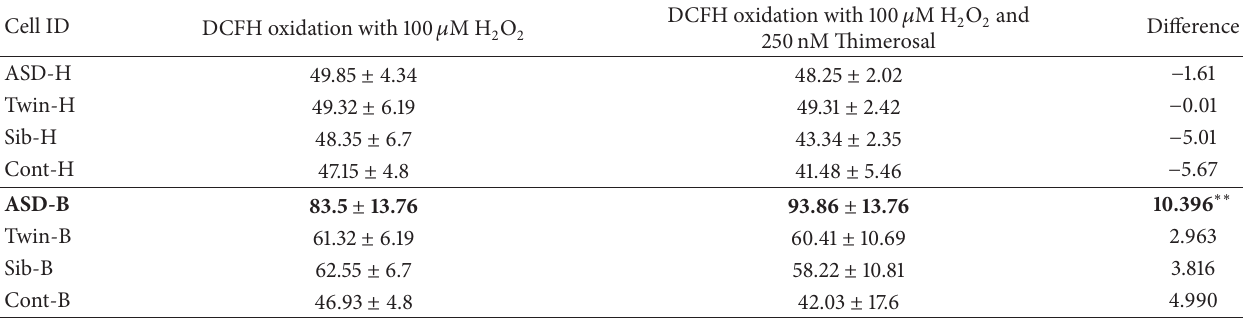
∗∗ Indicates statistically significant